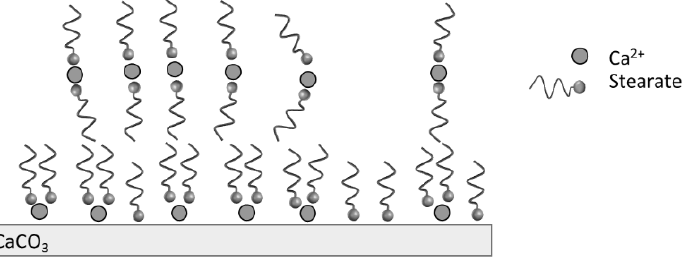
Figure 4. Illustration of stearate adsorption at the calcite surface.